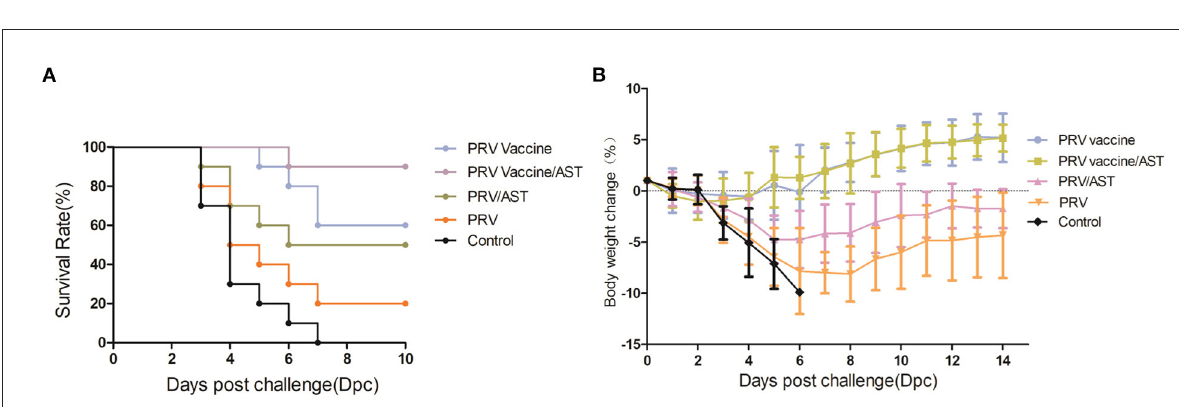
to enhance the protective effect of the PRV vaccine against PRV